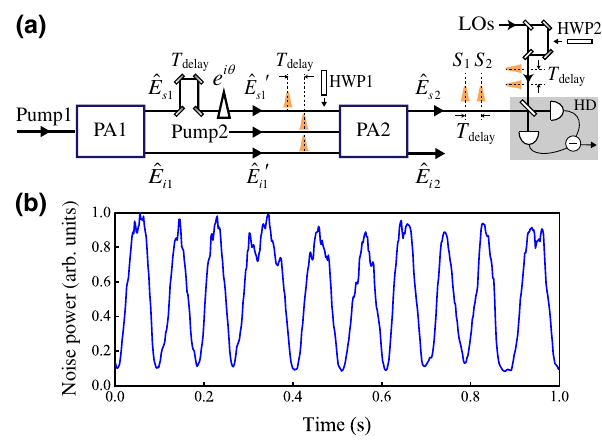
FIG. 6. (a) An unbalanced SU(1,1) interferometer with two pulse-pumped parametric amplifiers (PA1,PA2) and asynchro- nized signal arm. LO consists of two pulses to measure the asynchronized signal field for amplitude addition. HWP, half- wave plate. (b) Observed interference fringe in the homodyne